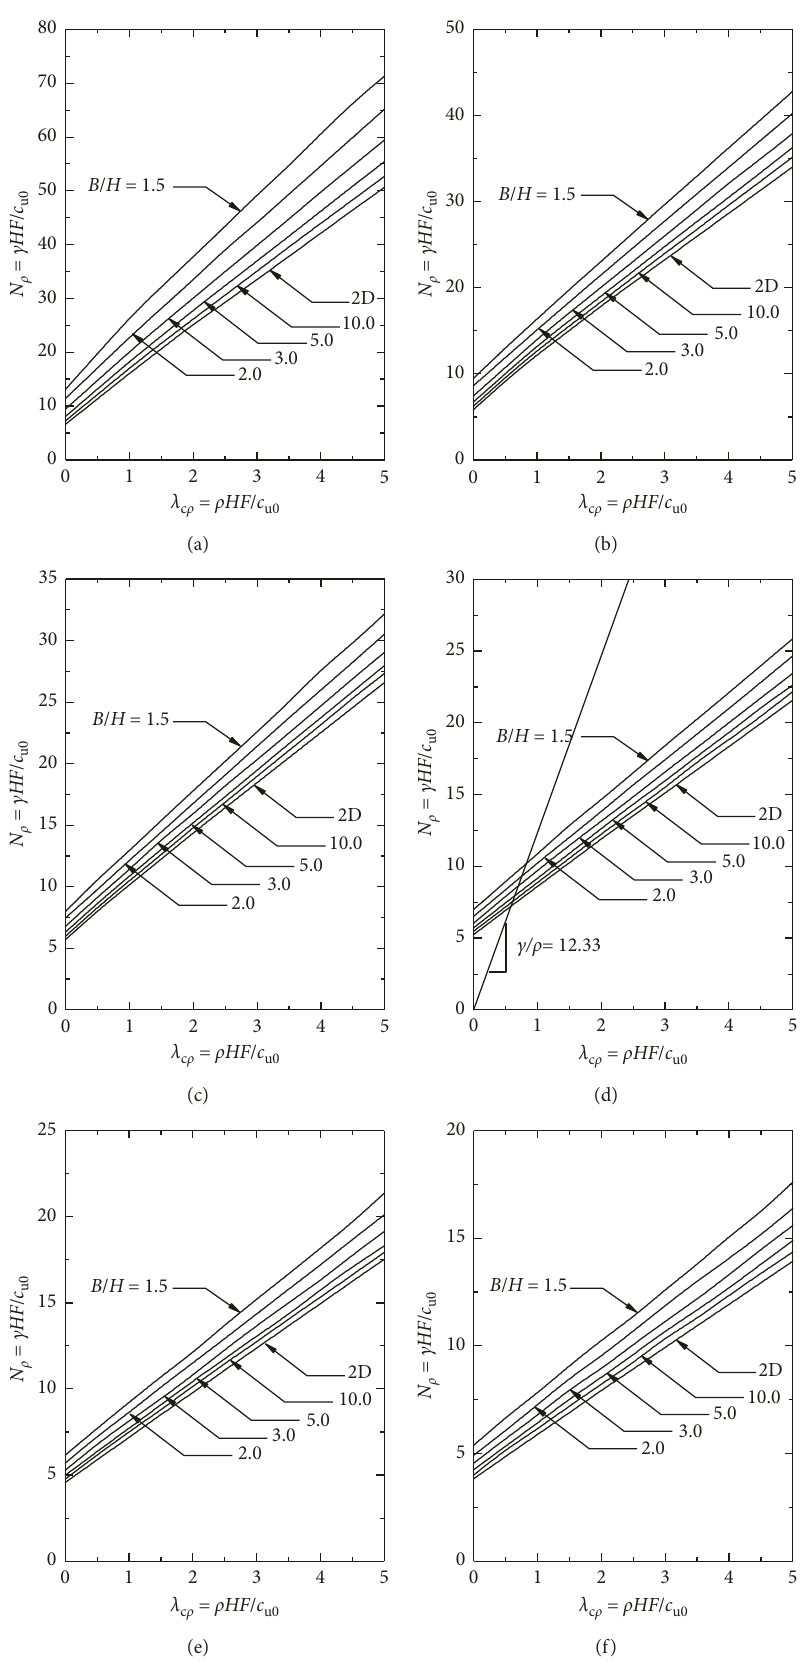
Figure 3: Static stability charts for cut slopes. (a) β